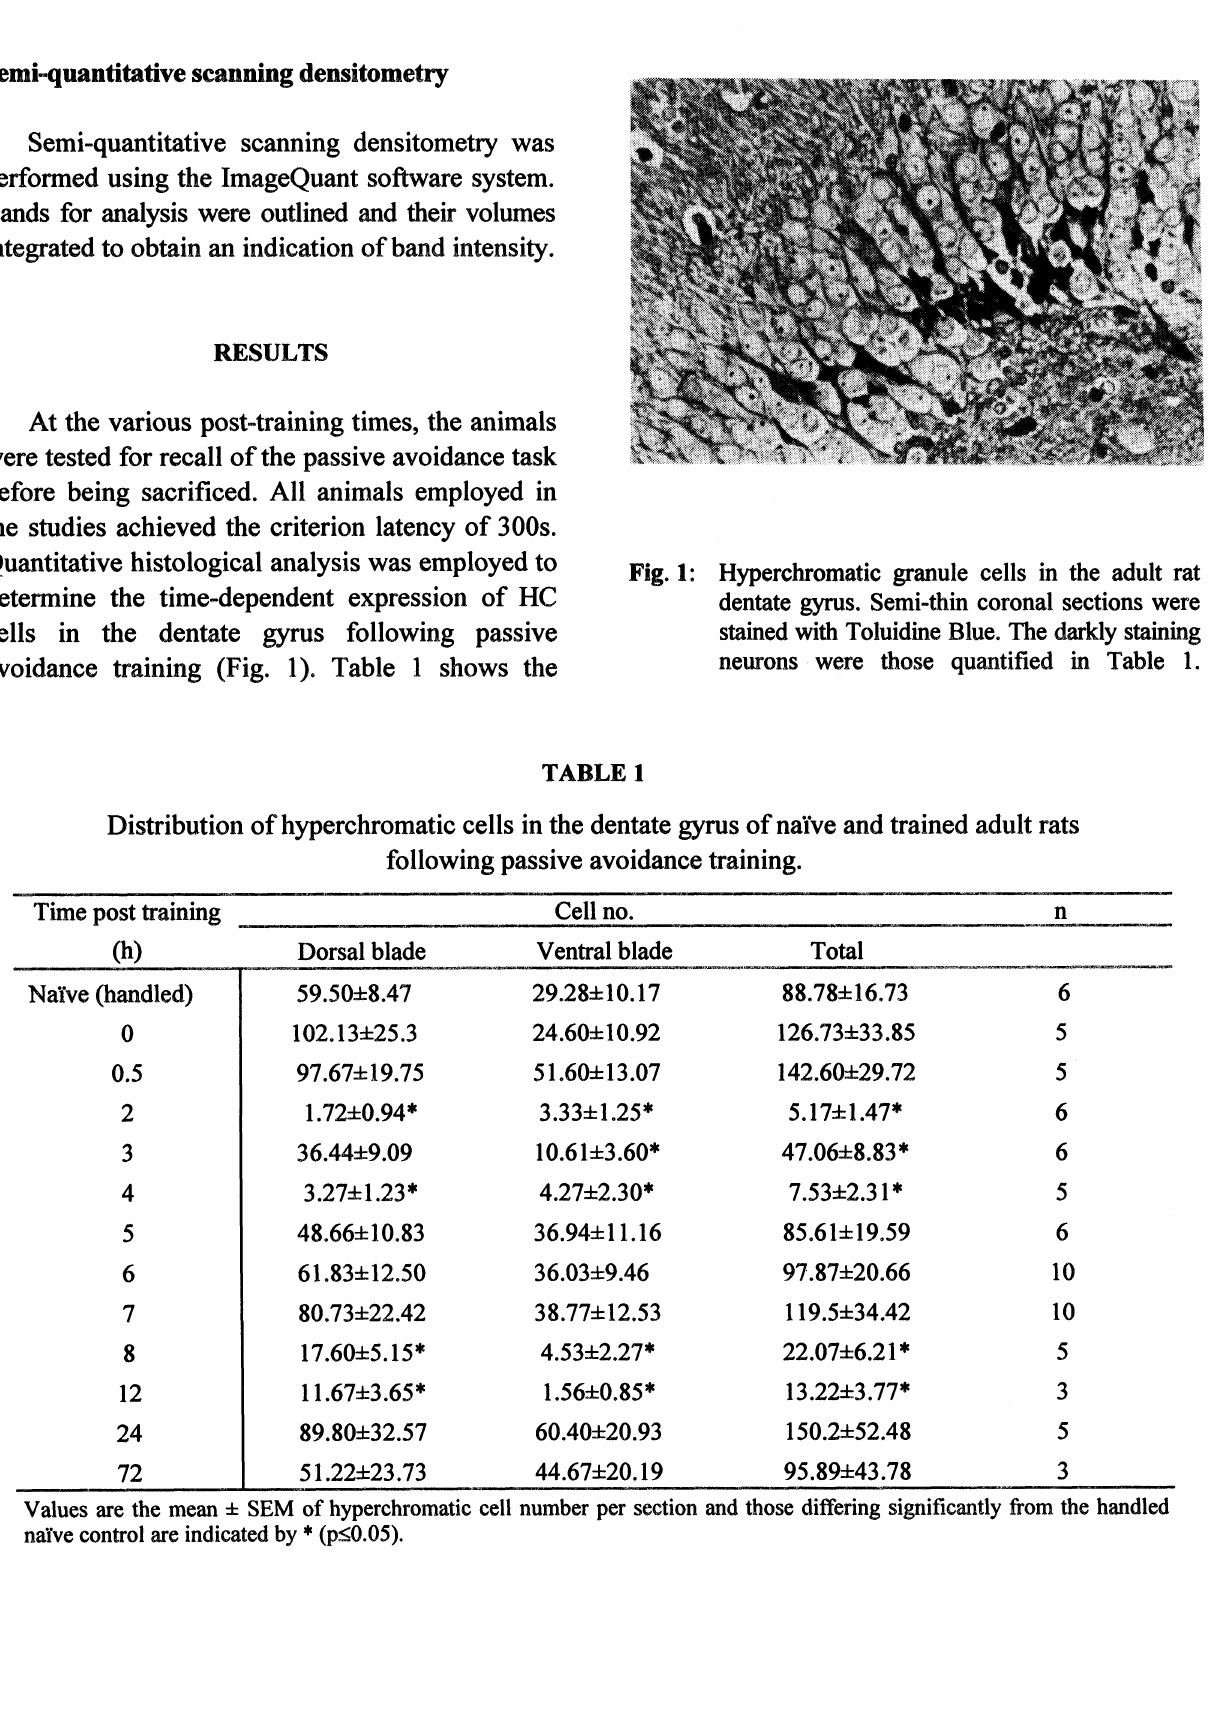
Fig. 1" Hyperchromatic granule cells in the adult rat dentate gyrus. Semi-thin coronal sections were stained with Toluidine Blue. The darkly staining neurons, were those quantified in Table 1.